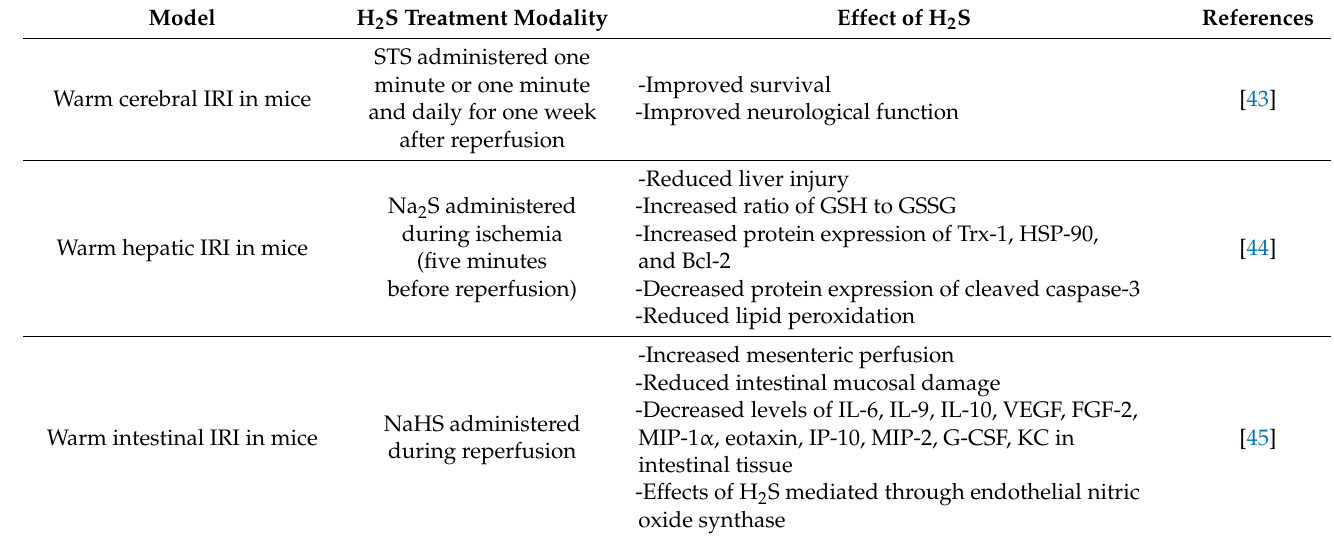
Table 1. Summary of the protective effects of exogenous H 2 S ischemic treatment and post-treatment in animal models of cold and warm